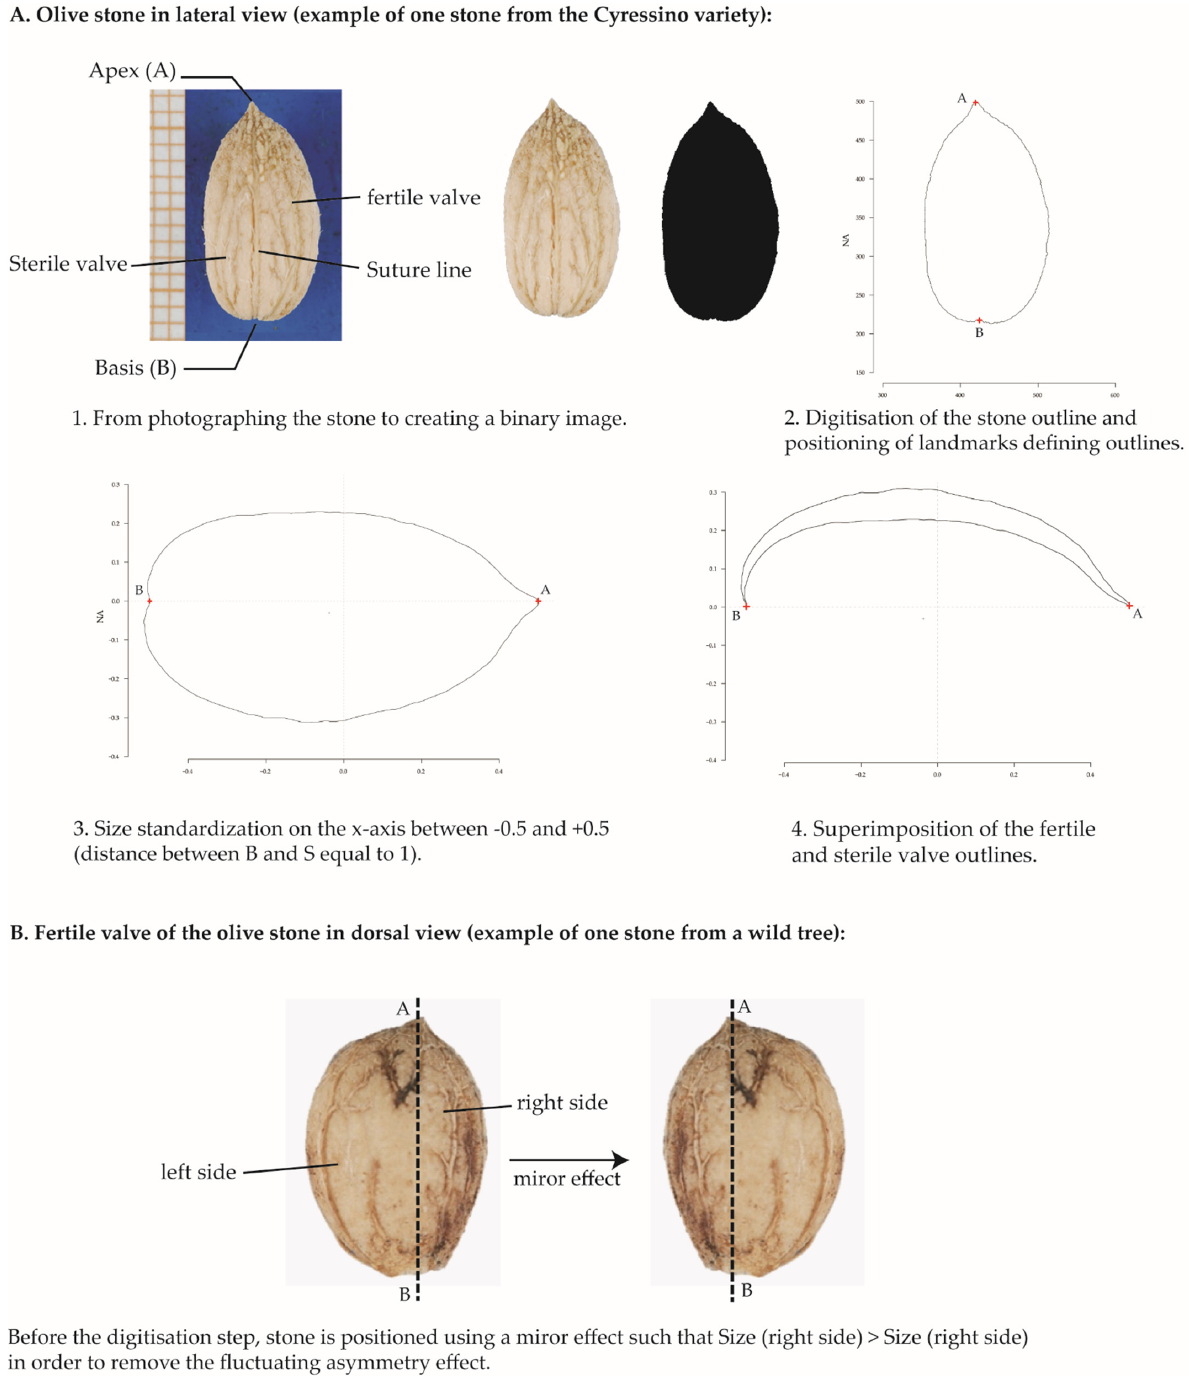
Figure 3. The morphometric protocol applied to olive stones described step by step (Sarah Ivorra and Jean-Frédéric Terral, CNRS/UM—ISEM).